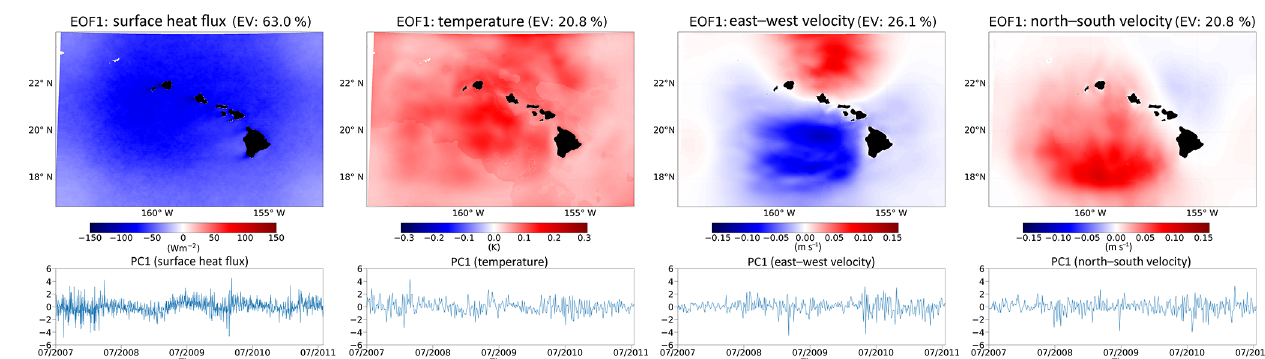
Figure 13. EOF1 and PC1 of initial condition increments for temperature, east–west velocity, and north–south velocity (all averaged 0– 100m) and of forcing perturbations applied to surface heat flux. The EOFs were calculated using the routines described in Dawson